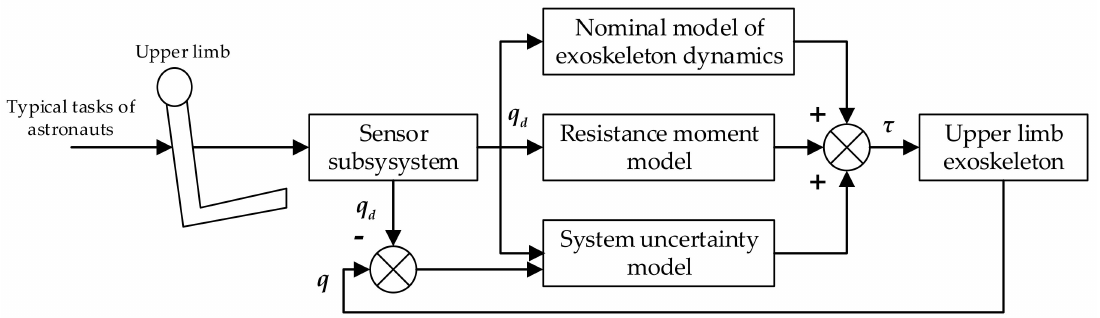
Figure 7. The schematic diagram of the overall control